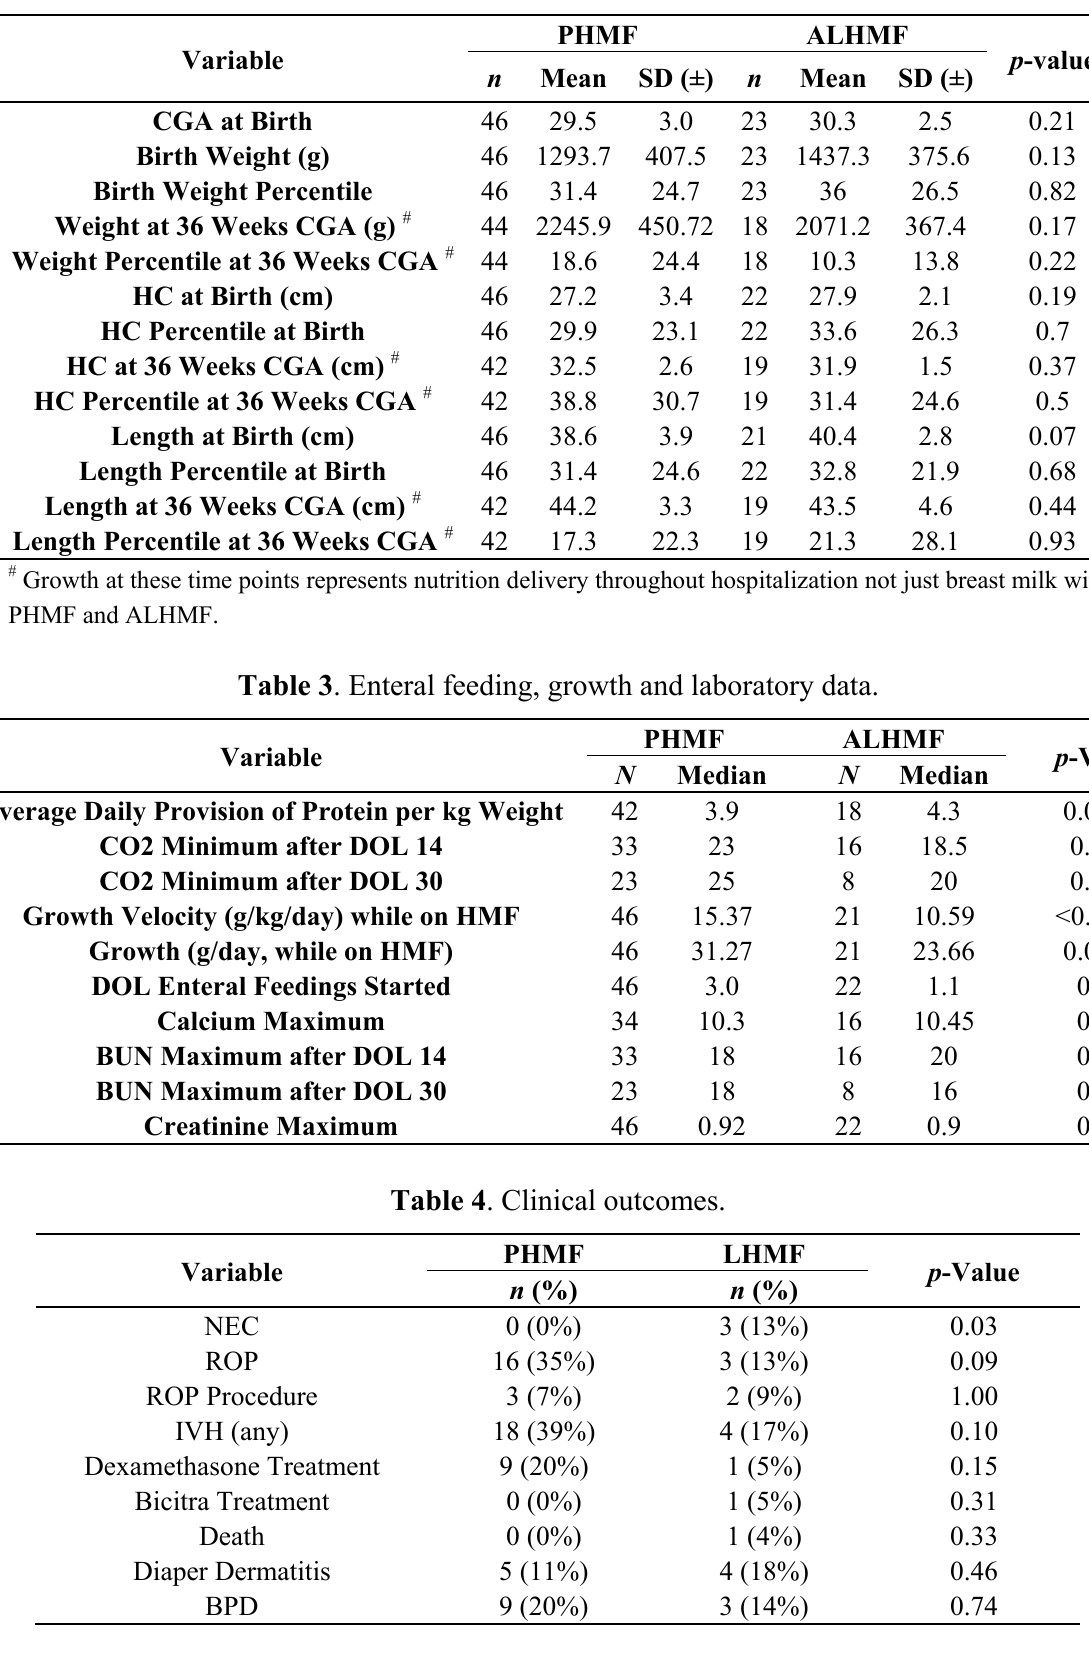
Table 2 . Baseline characteristics of the subjects.